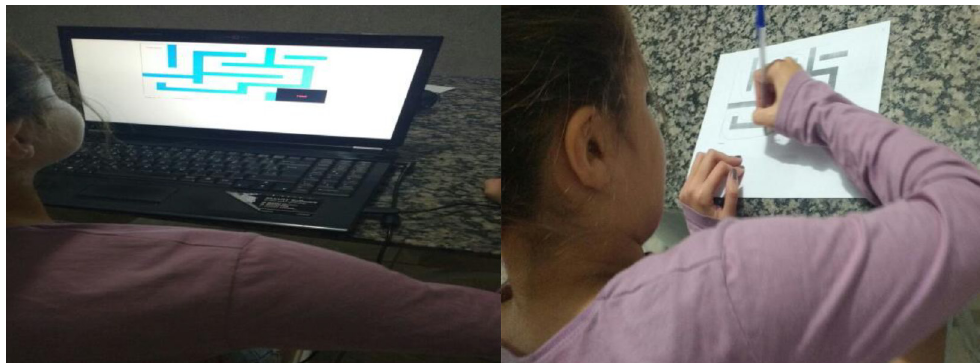
Figure 2 - Participant completing the maze test on a computer and on paper.